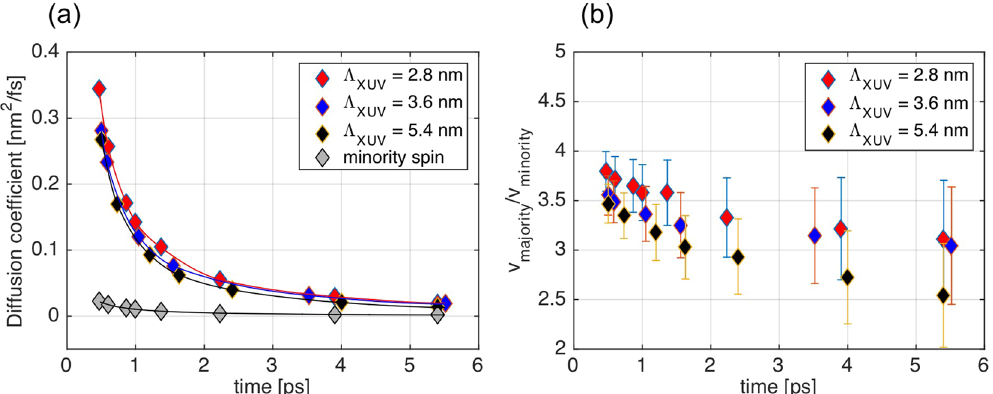
Figure 3. Diffusion coefficients and ratio of velocities for majority and minority spin carriers. ( a ) Diffusion coefficients at selected pump-probe delays for majority and minority spin carriers estimated from the widths of the respective profiles ( ↑ m x ( ) and ↓ m x ( ) ) across a domain wall. ( b ) Ratio of the velocities of majority and minority spin carriers at selected pump-probe delays. Solid lines are guide to the